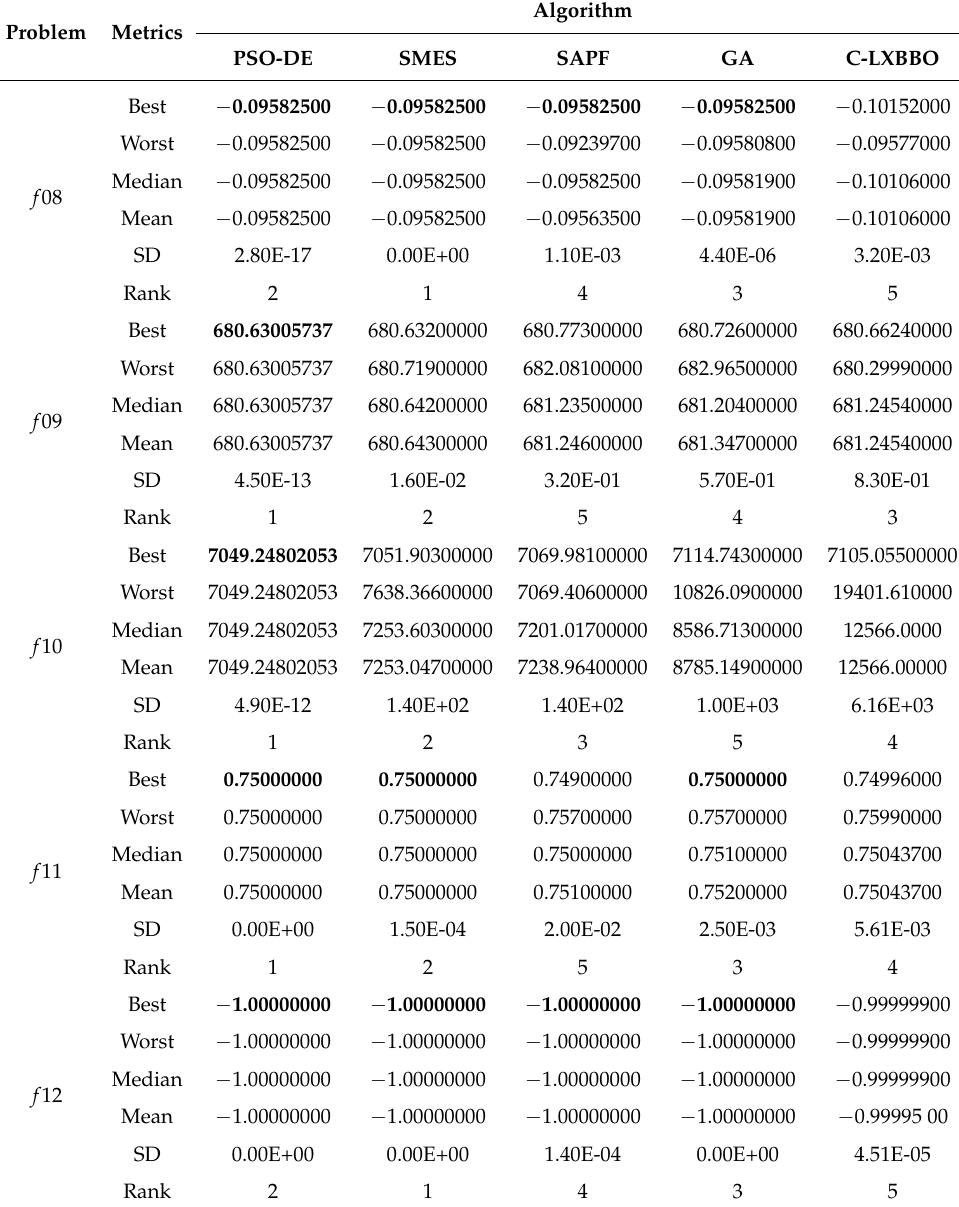
Table 6. The results of PSO-DE compared with other algorithms in the benchmark